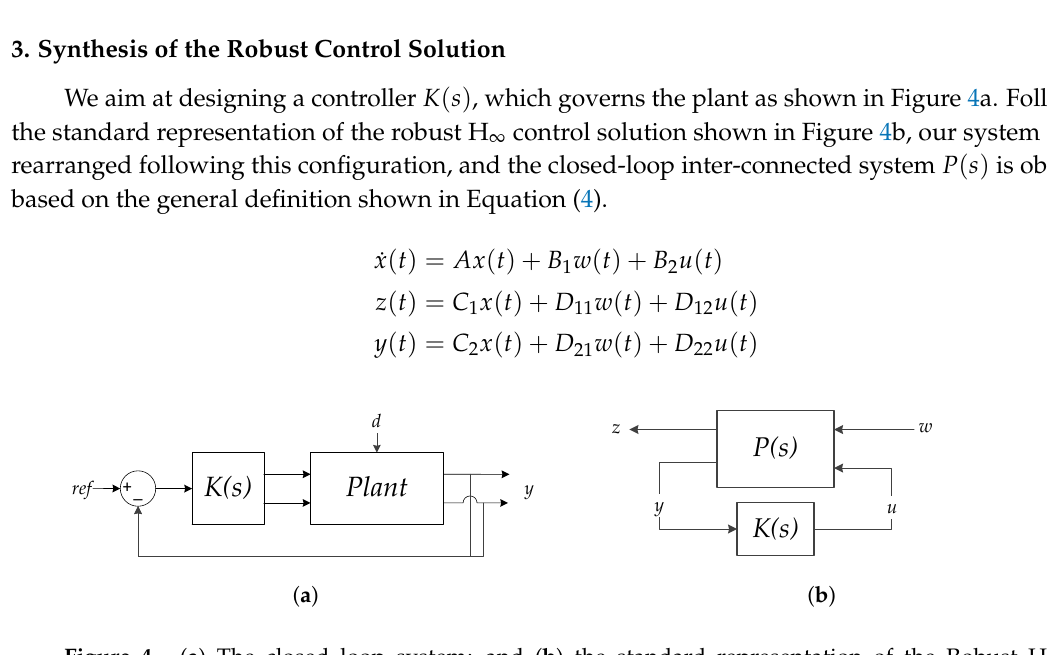
Figure 4. ( a ) The closed loop system; and ( b ) the standard representation of the Robust H ∞ control